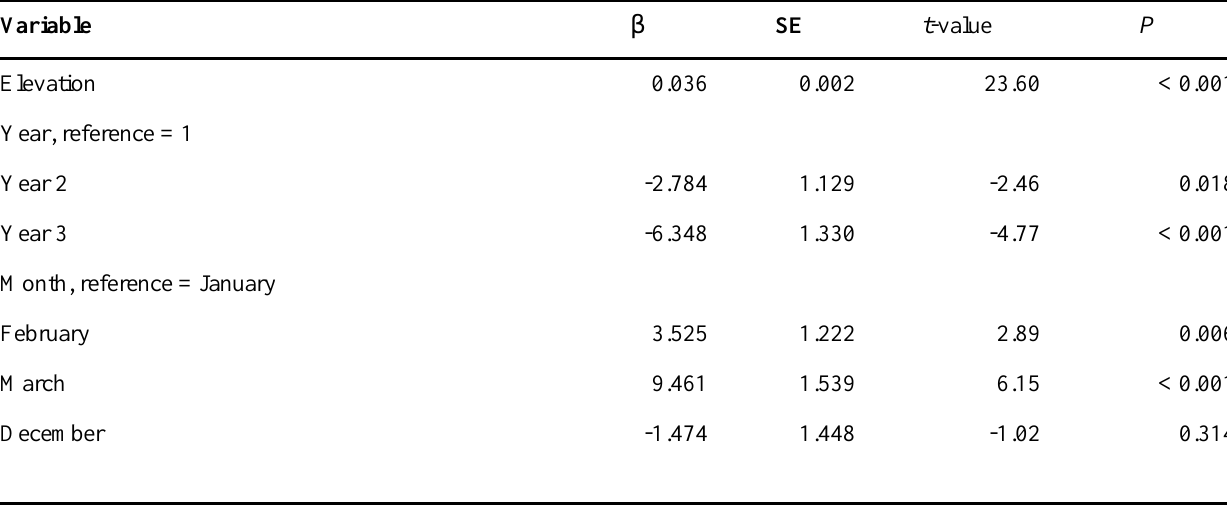
Table 4. Model parameters for the best linear mixed effects model predicting snow depth determined by Akaike Information Criteria